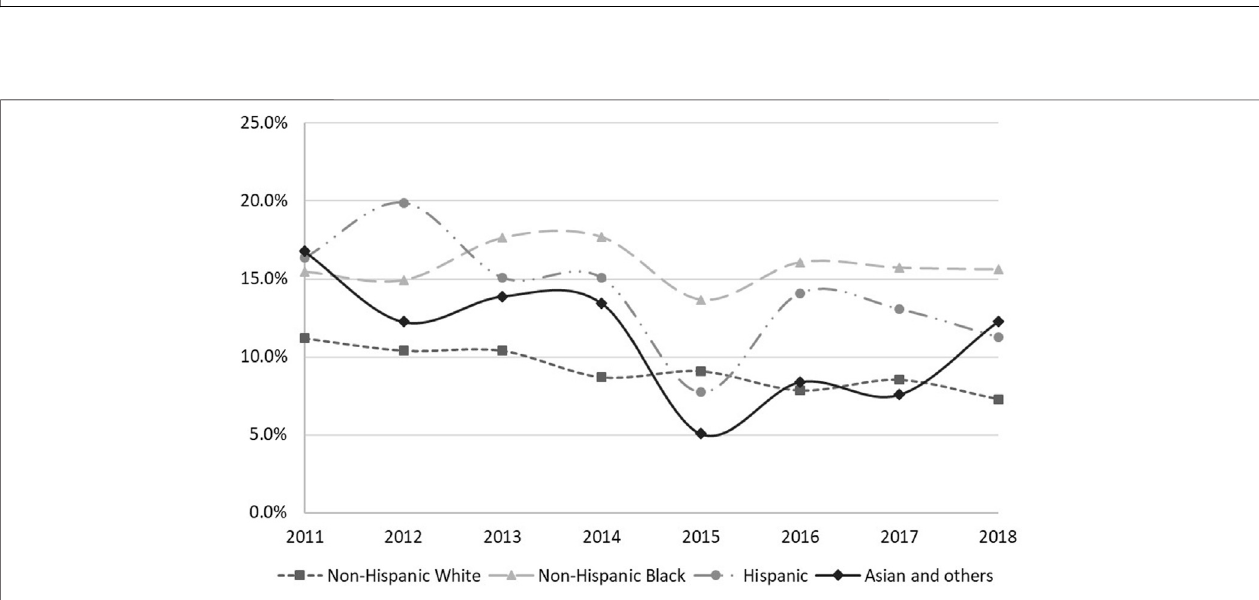
FIGURE 2 | Racial/ethnic disparities in cost-related medication nonadherence among cancer survivors between 2011 and 2018.